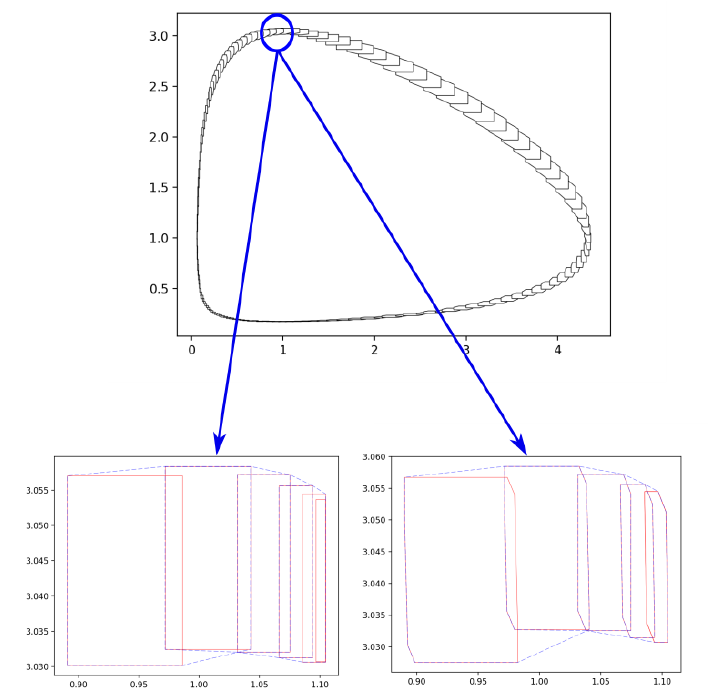
Figure 2. On top: reachable tube obtained with zonotopes—for example, (14) ( y 1 w.r.t. y 2 ). Bottom left and right: zoom on a small part computed with intervals or zonotopes